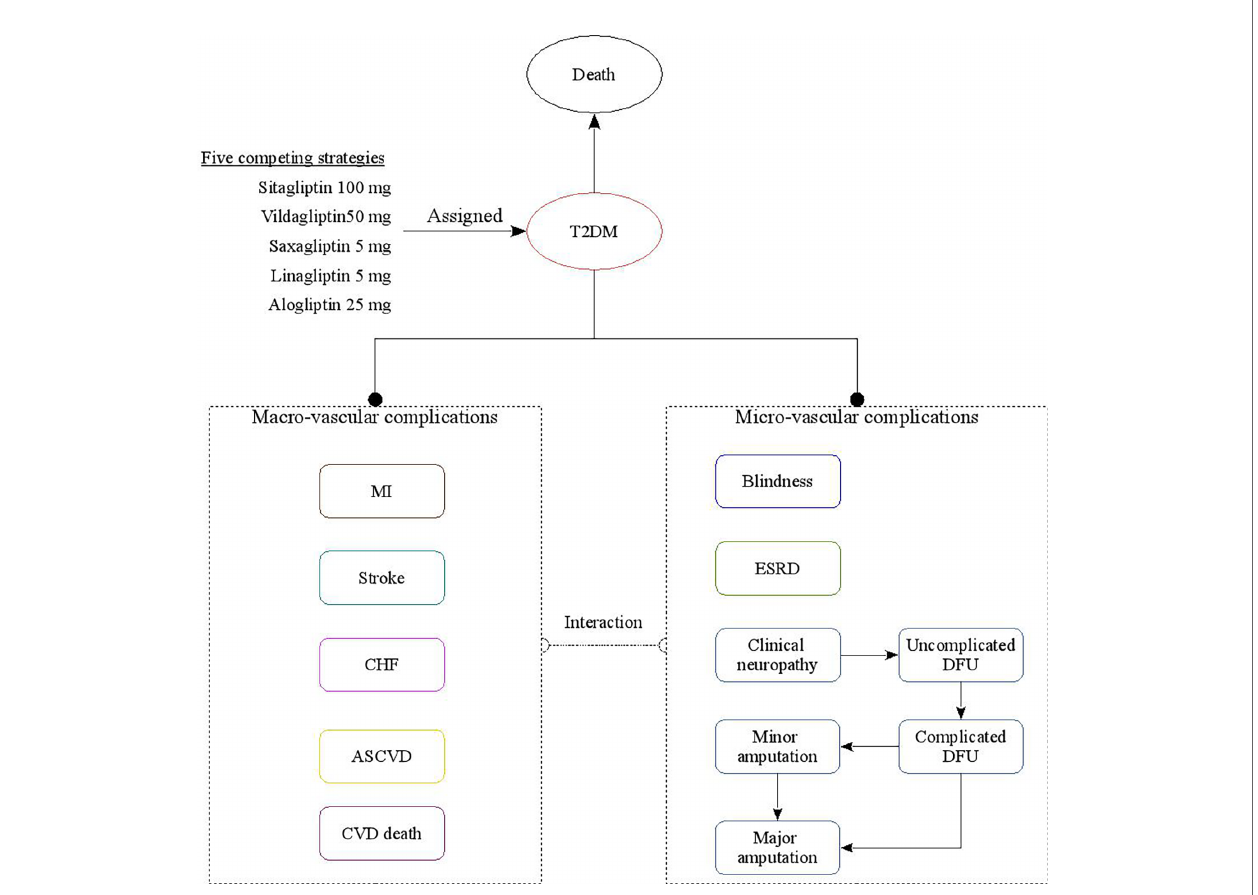
FIGURE 1 | The structure of the Chinese T2DM health policy